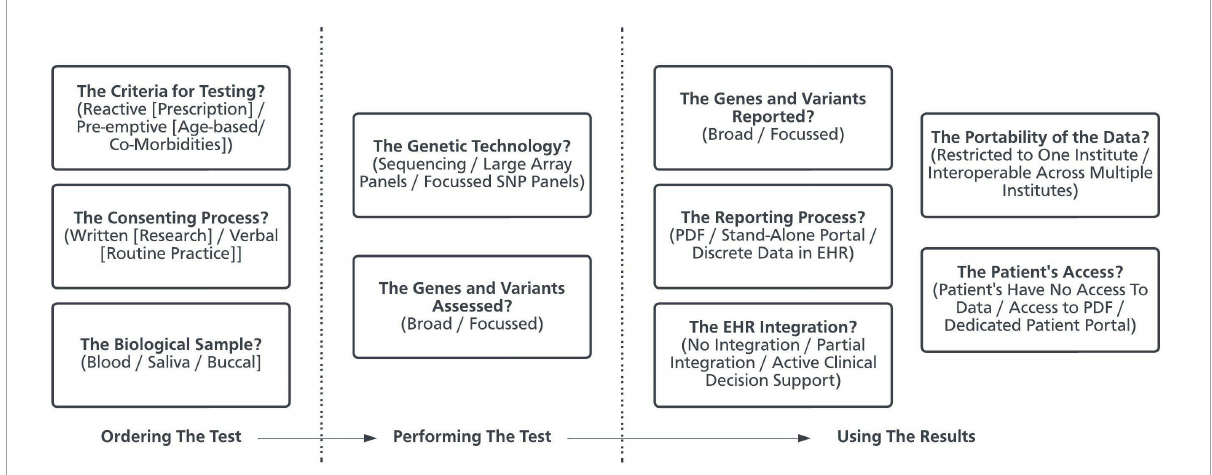
FIGURE1 The decisions made when developing a pharmacogenetic program. Using pharmacogenetics in clinical practice is a complex healthcare intervention and is made up of many components (16, 80). This schematic presents some of the key design decisions made by organizations when developing a pharmacogenetic service. PDF, Portable Document Format. EHR, Electronic Health Record. SNP, Single Nucleotide